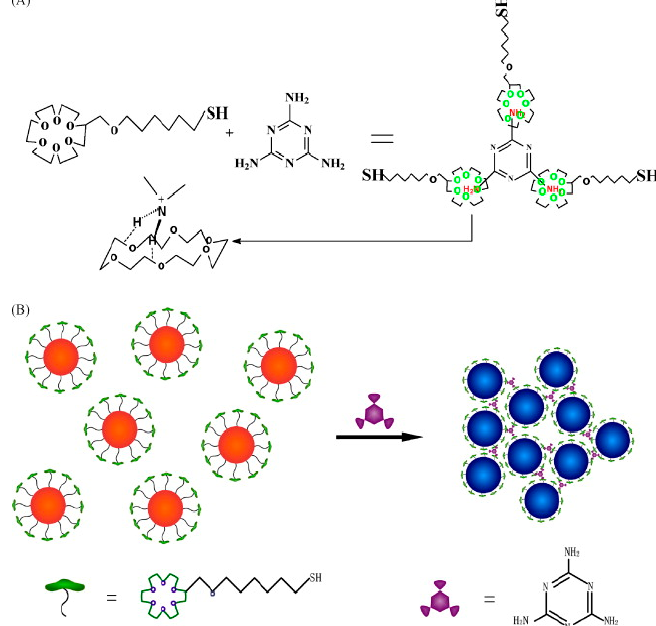
Figure 18. Schematics of the melamine sensing with 18-crown-6-thiol-modified GNPs. ( A ) Specific interaction in the complex between the crown ether and melamine; ( B ) melamine-induced aggregation of 18-crown-6-thiol-modified GNPs (reproduced with permission from Reference [121]). Aggregation and electrostatic forces involved tactics were also described by a few reports [122,